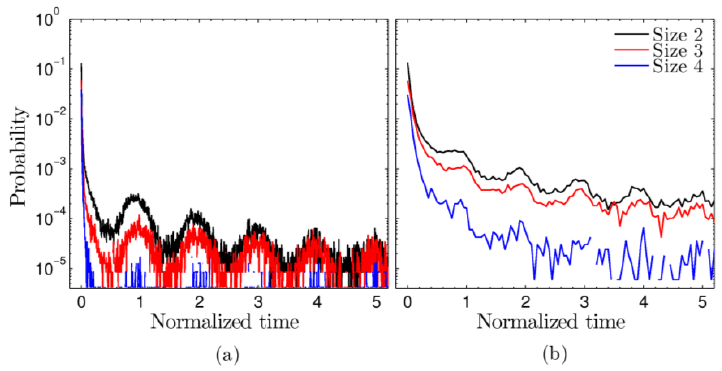
Figure 7. Probability of a given time span between the break of an aggregate and the cyclic formation of the same aggregate. Data are shown for frequency-amplitude combinations ( a ) ω = 6.28 × 10 −4 , γ 0 = 3.59; and ( b ) ω = 6.28 × 10 −3 , γ 0 = 0.36 . Time is normalized by the period of an oscillation.